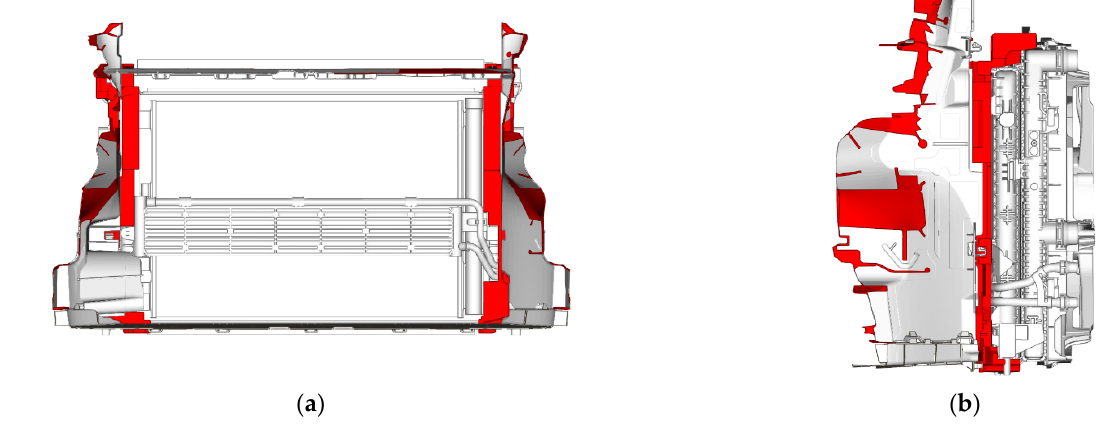
Figure 10. Optimized cooling module of PHEV . ( a ) Optimized structure front view; ( b ) optimized structure side view.